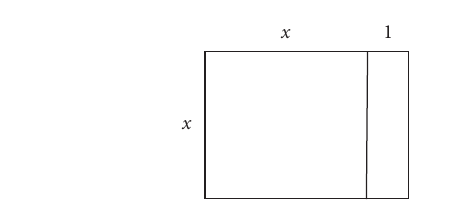
Figure 2: Illustration for a question used in the interview.